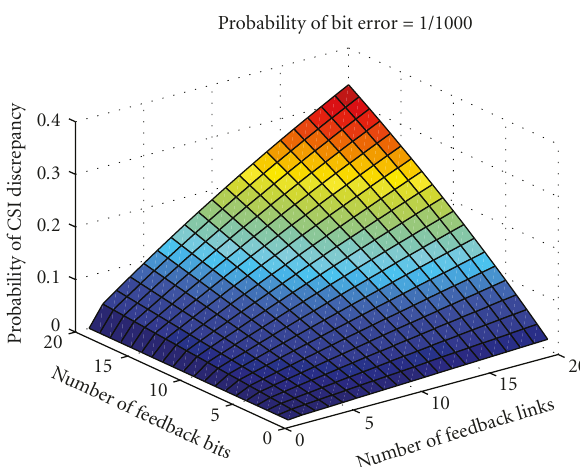
Figure 4: A plot of the probability of CSI discrepancy between the collaborating BSs P d in the decentralised framework as a function of the number of independent feedback links (equal to the number of involved BSs) and the number of feedback bits (18). The assumed bit error probability is P e = 10 − 2 .